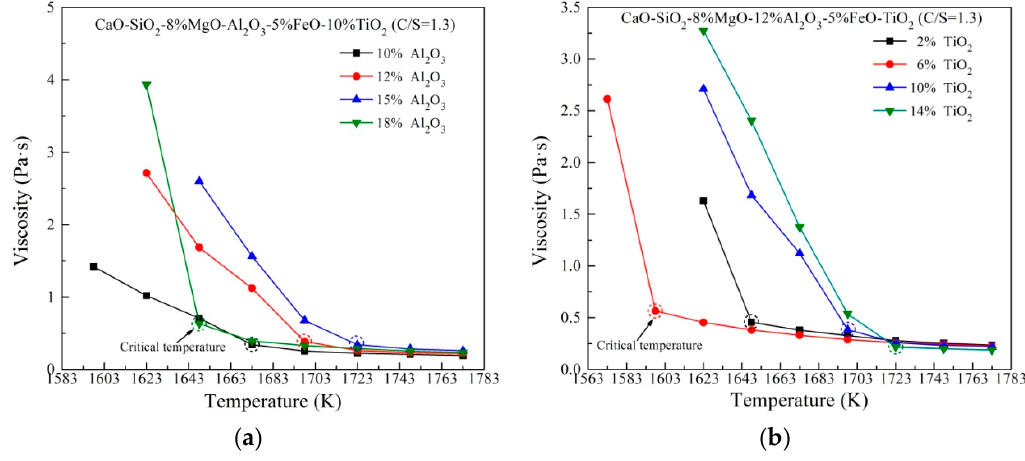
Figure 2. Viscosity of slag containing different ( a ) Al 2 O 3 content and ( b ) TiO 2 content against temperature.